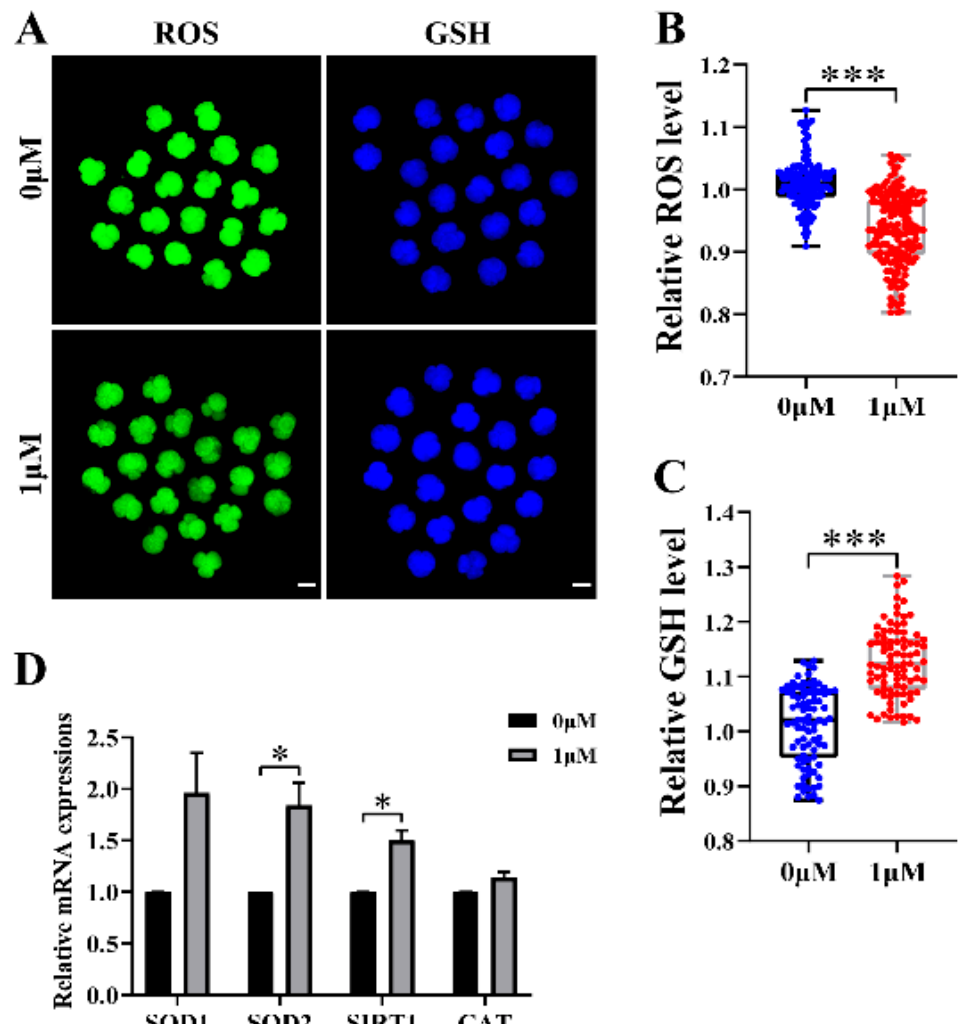
Figure 3. Effect of chrysoeriol (CHE) on the expression levels of ROS and GSH in embryos. ( A ) Rep- resentative pictures of H2DCFDA and CMF2HC staining in 4-cell stage embryos. Scale bar = 100 µ M. ( B ) Relative fluorescence intensity changes of ROS in the control (0 µ M) group (n = 137) and the CHE-treated (1 µ M) group (n = 164) R = 5. Data represent medians and maxima and minima. Significant differences are shown as *** ( p < 0.001). ( C ) Relative fluorescence intensity changes of GSH in the control (0 µ M) group (n = 85) and the CHE-treated (1 µ M) group (n = 85) R = 5. Data represent medians and maxima and minima. Significant differences are shown as *** ( p < 0.001). ( D ) Changes in gene expression levels related to oxidative stress after the addition of CHE. Significant differences are shown as * ( p <